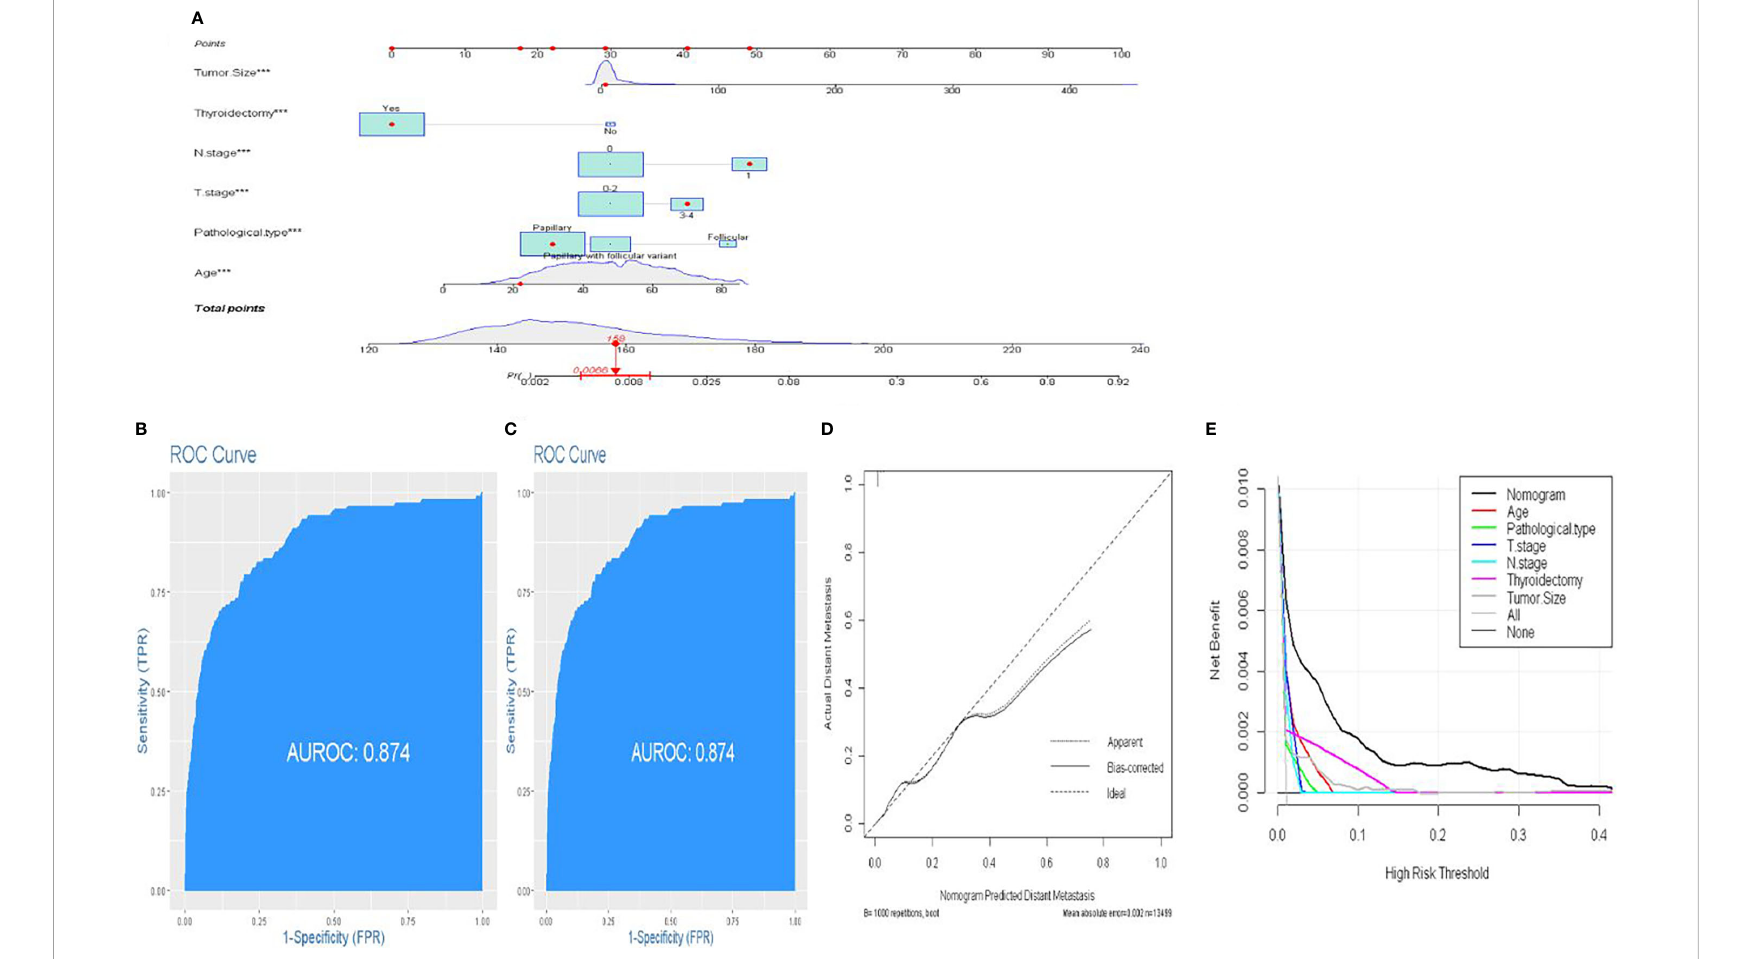
FIGURE 3 A novel nomogram predicting distant metastasis. (A) Nomogram predicting the probability of DM. Instructions: Locate the patient characteristics of each variable on its respective axis. Draw a line to the “ dot ” scale to get a score for each variable. Find the total score on the total score scale based on the sum of the points of all variables. Draw a line to the end scale. (B, C) The ROC curve of nomograms in training and validation cohorts. (D) Calibration curves of the nomogram for the probability of DM. (E) Decision curve analysis for